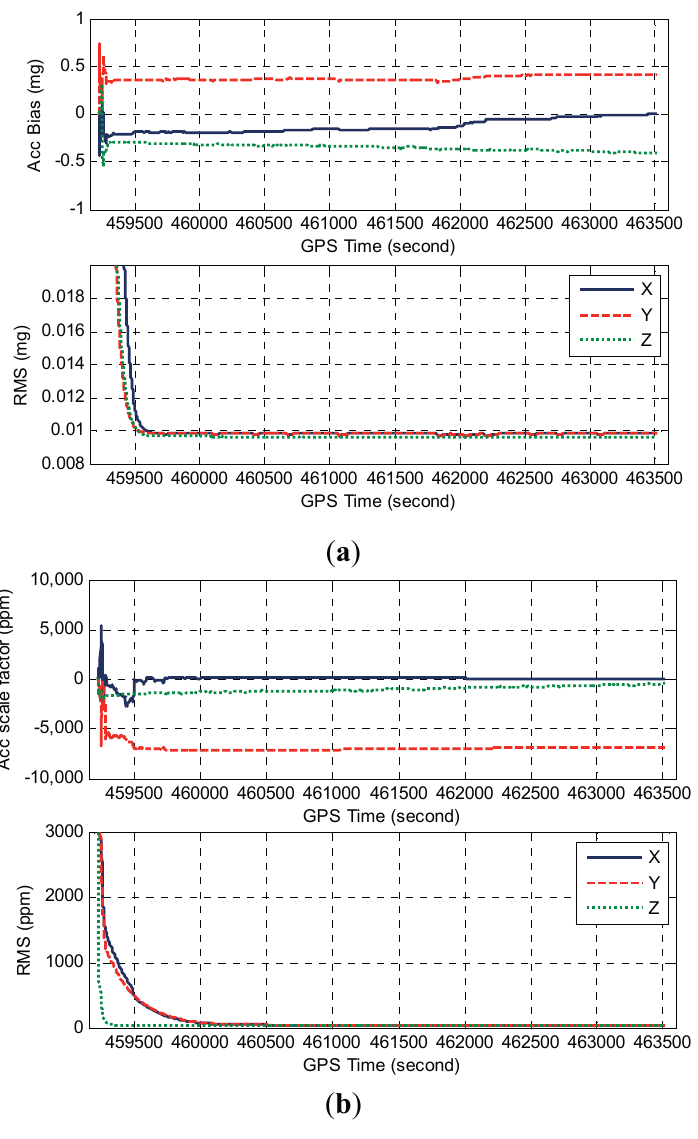
Figure 9. ( a ) Estimated accelerometer biases and RMS; ( b ) Estimated accelerometer scale factors and